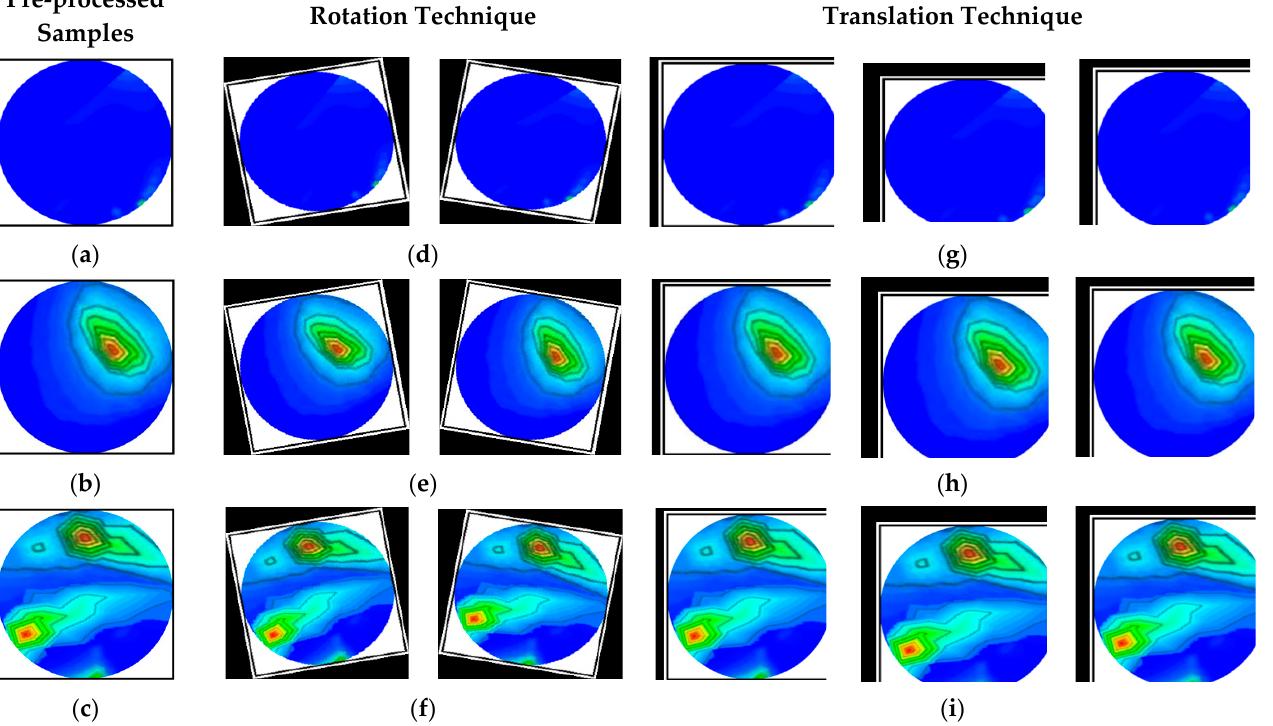
Figure 10. Augmented sample of training set: ( a – c ) pre-processed non-tumor, single tumor, and double tumor images, ( d – f ) images after rotation by 20 degrees counterclockwise and clockwise for non-tumor, single tumor, and double tumors, and ( g – i ) images after three percent horizontal, five percent vertical and horizontal, and five percent horizontal and three percent vertical translation for non-tumor, single tumor, and double tumors.